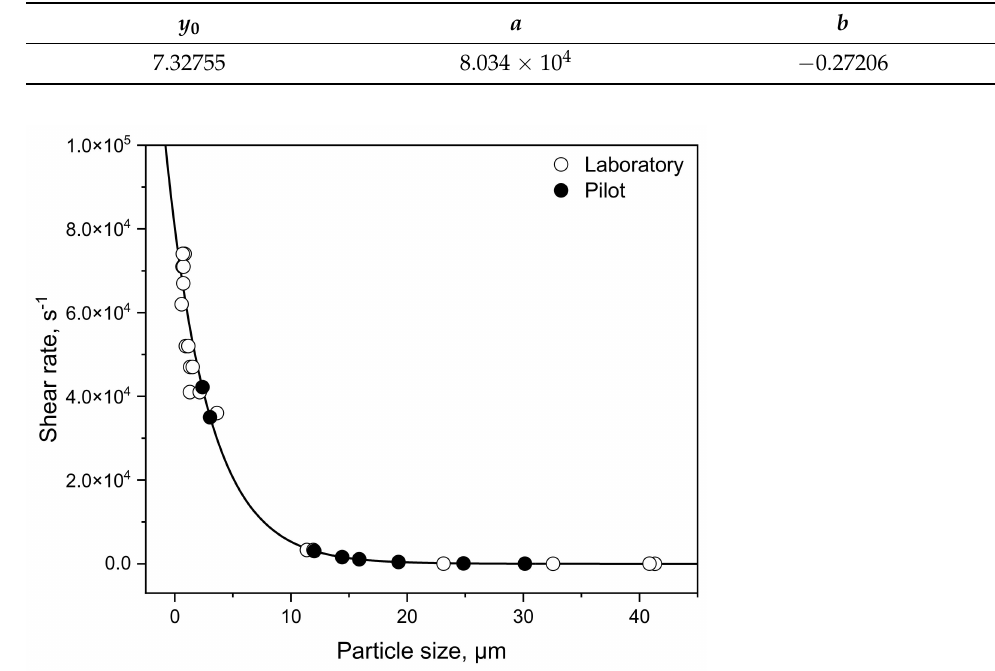
Table 3. Fit parameters y 0 , a , and b of modeling the shear rate in laboratory scale by the fit equation.